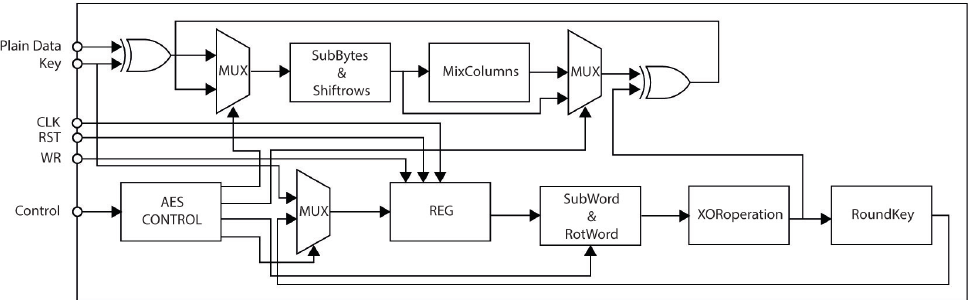
Figure 13. Block diagram of the simple hardware architecture 1R without fault detection or pipeline